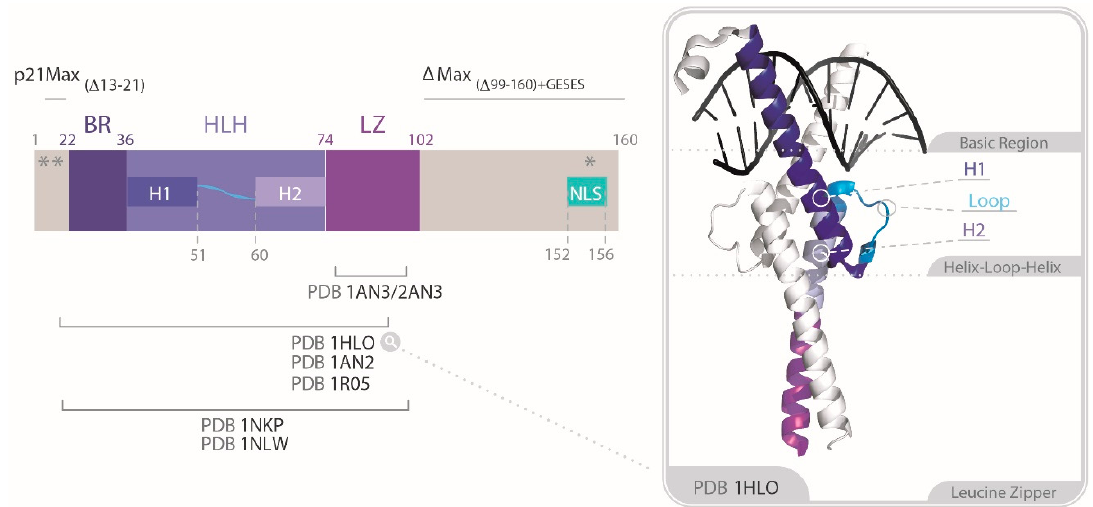
Figure 3. Schematic representation of the modular structure of p22MAX (MYC-associated factor X protein, UniProtKB code P61244). The naturally occurring (p21MAX) and oncogenic (DeltaMAX) MAX variants are identified. The three phosphorylation sites target of Casein Kinase II (CKII) are identified on MAX by the symbol * [38], both increasing the on- and o ff -rates of the homo- and heterodimers on DNA in vivo, are indicated by stars. The crystal structure of the DNA-bound p21MAX is displayed on the right. One monomer highlights the Basic Region in dark blue, the Helix-Loop-Helix domain in di ff erent shades of blue corresponding to H1, Loop and H2 elements and the Leucine Zipper in purple. The other monomer is shown in white while the double stranded DNA E-box is displayed in black.